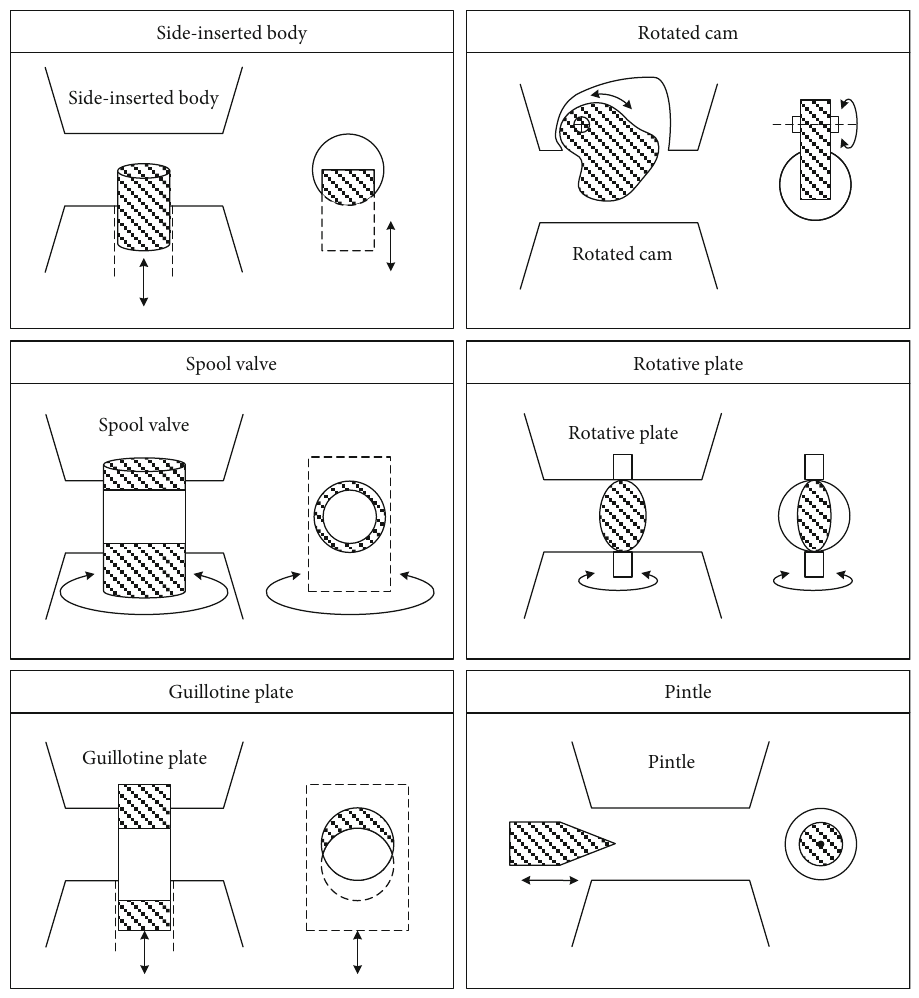
Figure 1: Several application types of the throttling valves.